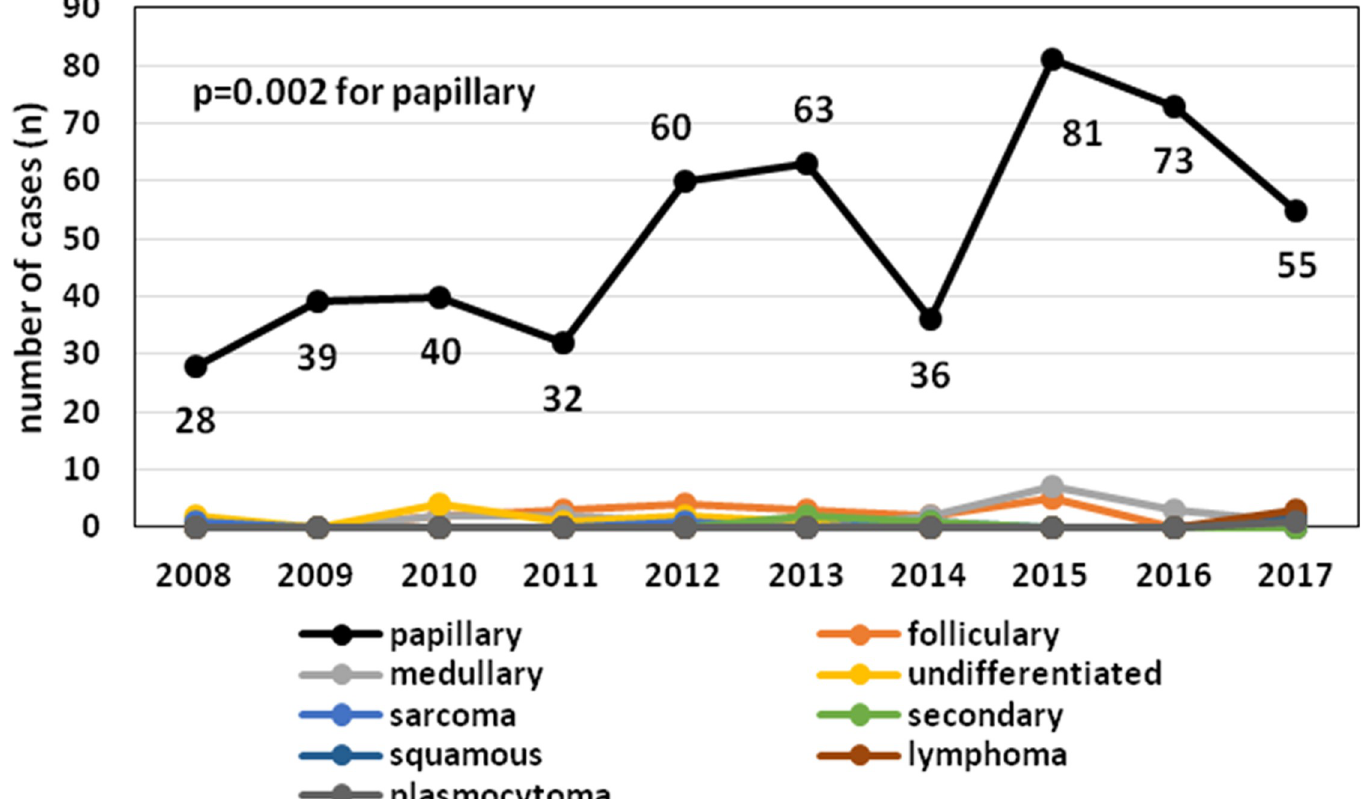
Fig 2. The number of patients with papillary thyroid cancer increased significantly compared to that of the patients with other types of thyroid cancer from 2008– 2017 (p = 0.024).